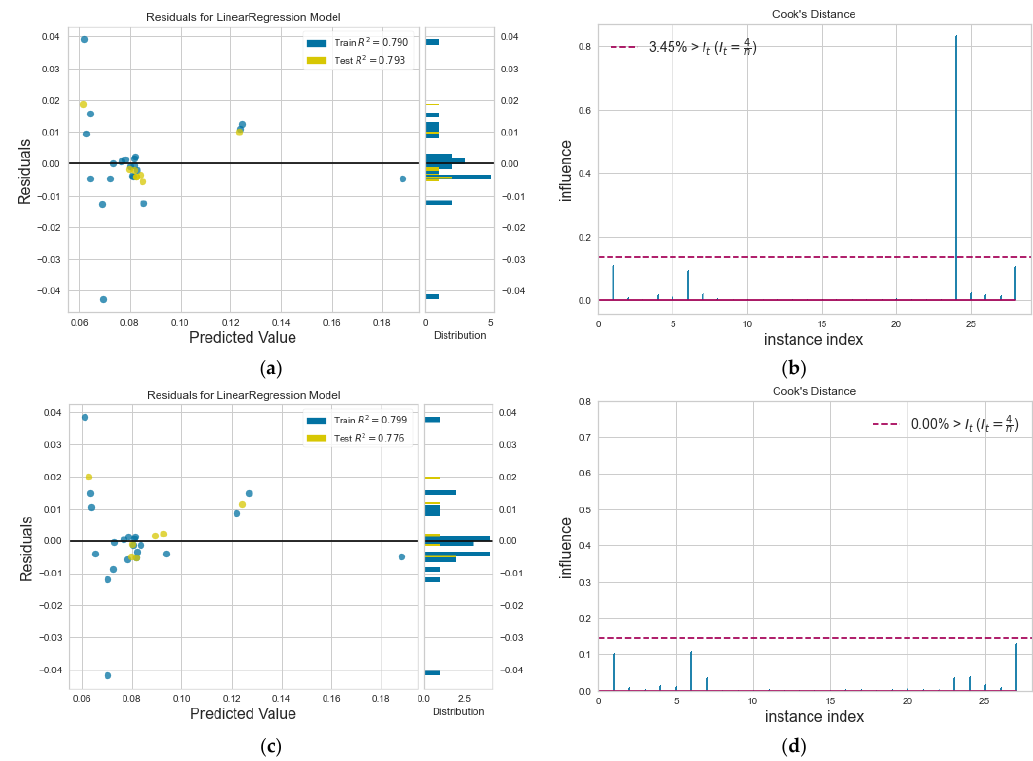
Figure 6. ( a ) Residuals plot and ( b ) Cook’s distance for D , and, after the removal of outliers from the dataset, ( c ) new residuals plot and ( d ) new Cook’s distance. For the shear viscosity, η , a residual plot for train and test data is shown in Figure 7a. Although data is mainly scattered around the horizontal line, yet, there are scarce points that keep the R 2 value low. The Cook’s distance (Figure 7b) depicts these outliers, and after their removal, we observe that residuals have significantly improved and data dis- tribution is around zero, as shown from the respective histogram plot in Figure 7c. No